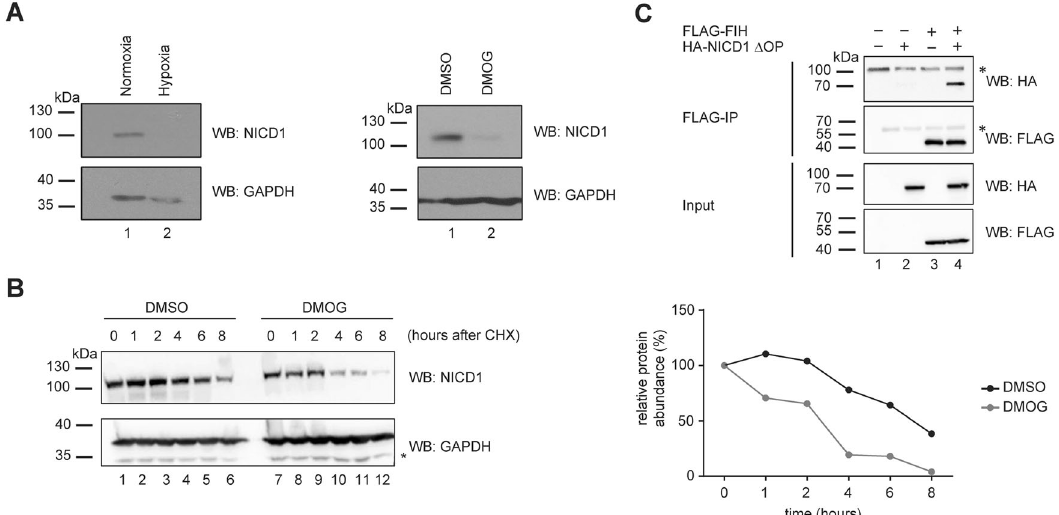
Fig. 2 Hypoxia destabilizes the active cleaved NICD1 protein. A Beko cells were kept for (left) 12 h in hypoxia (1% O 2 ) or normoxia (5% O 2 ) as control or, alternatively, (right) treated with 0.5 mM DMOG or with DMSO as a control for 24 h. Whole-cell extracts (WCE) were analyzed by Western blotting (WB) versus the endogenous cleaved NICD1 protein or GAPDH as a loading control. B DMOG treatment destabilizes the NICD1 protein. Beko cells were treated for 24 h with 0.5 mM DMOG or DMSO as control and, after the fi rst 16 h, protein synthesis was blocked by adding 50 µg/mL cycloheximide (CHX). Samples were collected at the indicated time points. WCE was analyzed by WB versus endogenous cleaved NICD1 or GAPDH as a loading control. Quanti fi cation of the NICD1 levels normalized to GAPDH is shown on the right. The experiment was repeated independently three times. C FIH and NICD1 Δ OP interact with each other. Phoenix TM cells were transfected with plasmids encoding HA-tagged NICD1 deleted of the OPA and PEST domains ( Δ OP) and/or FLAG-tagged FIH. WCE were subjected to